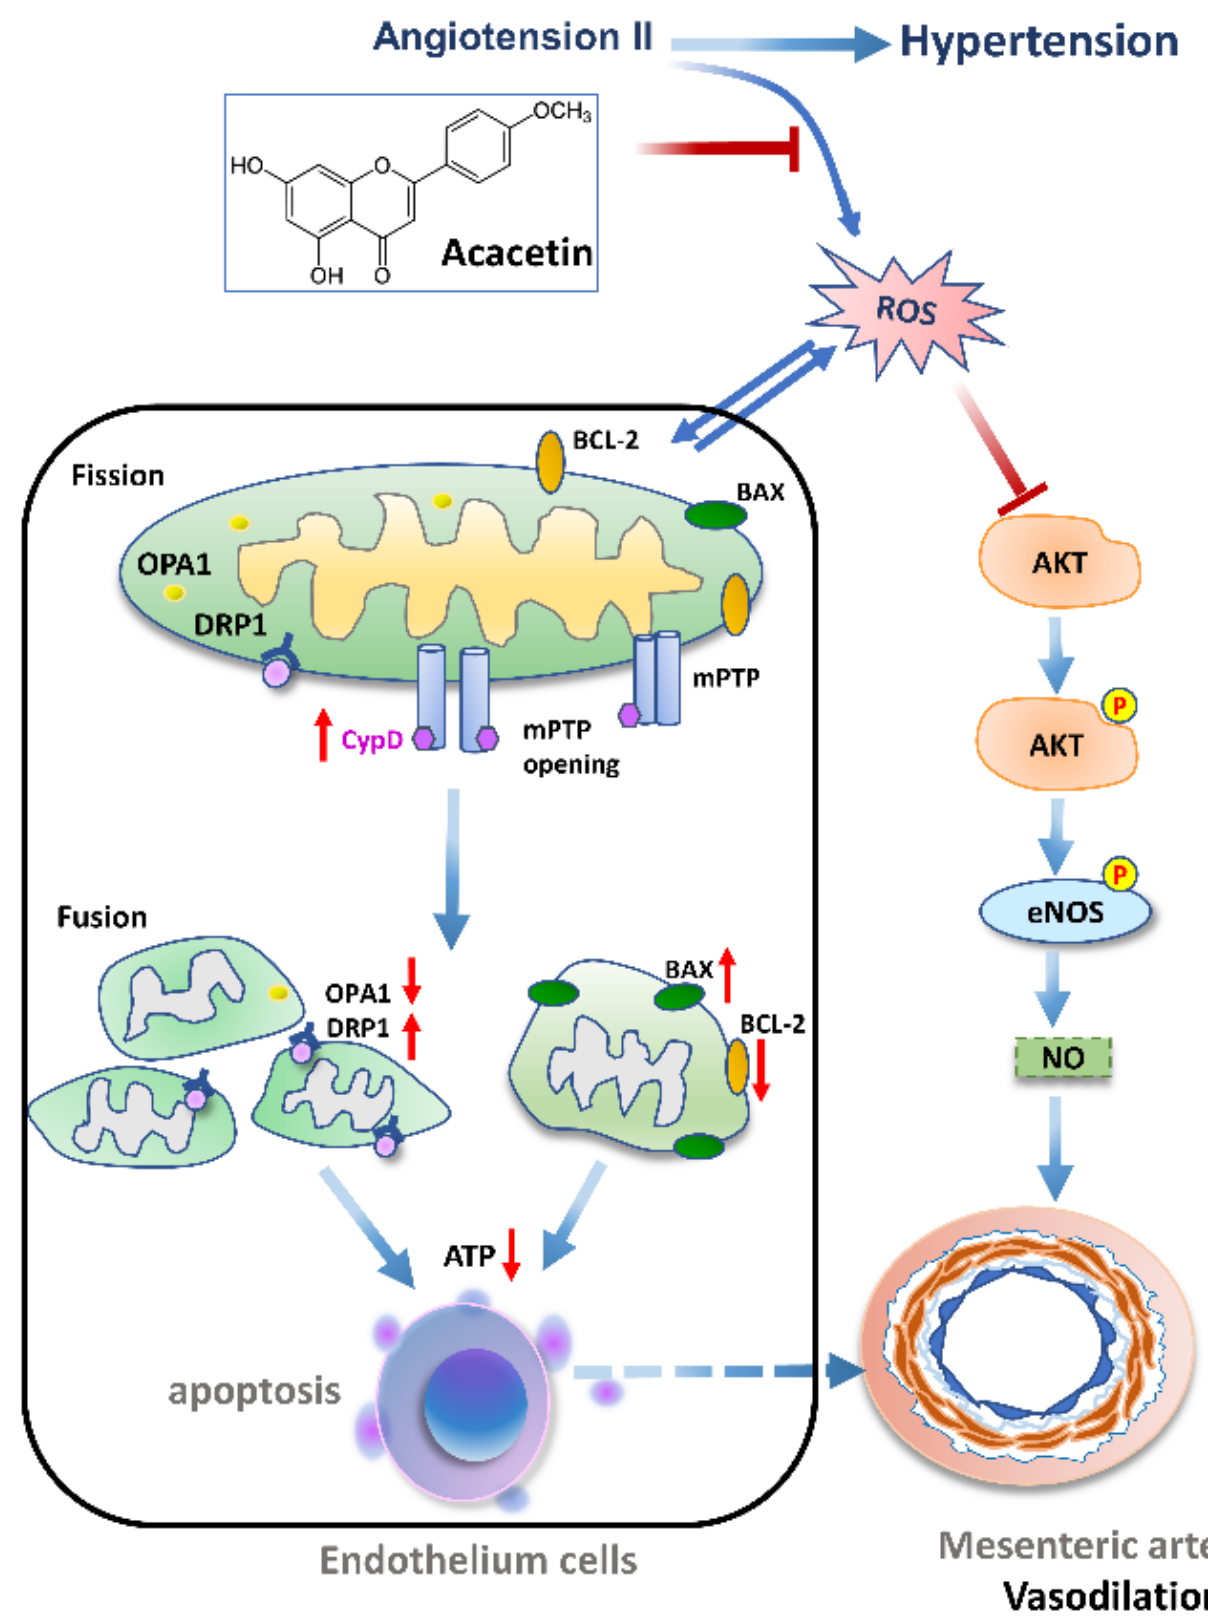
Figure 7. The schematic diagram describing the protective mechanism of acacetin against endothelial injury in hypertension.